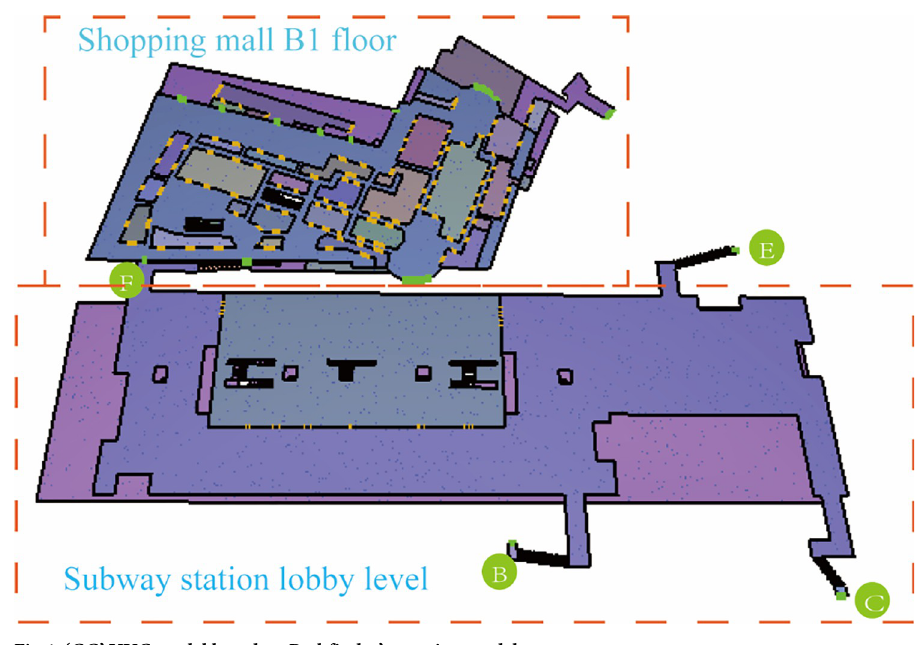
Fig 4. ‘GG’ UUC model based on Pathfinder’s steering